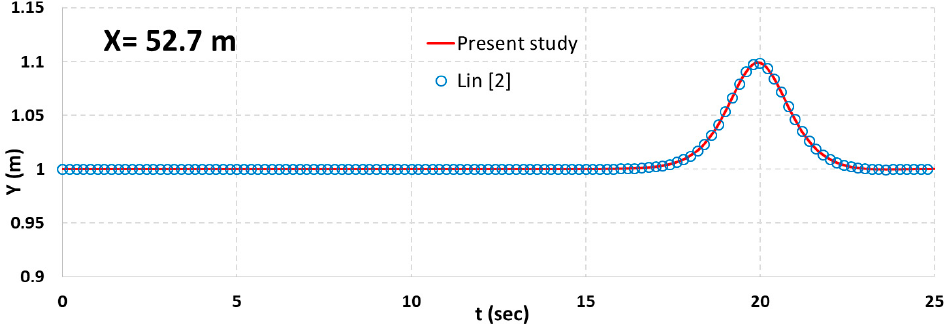
Figure 5. A comparison of the time history of the free-surface elevation at x = 52.7 m between the present study (solid line) and the Lin [2] study (circle).